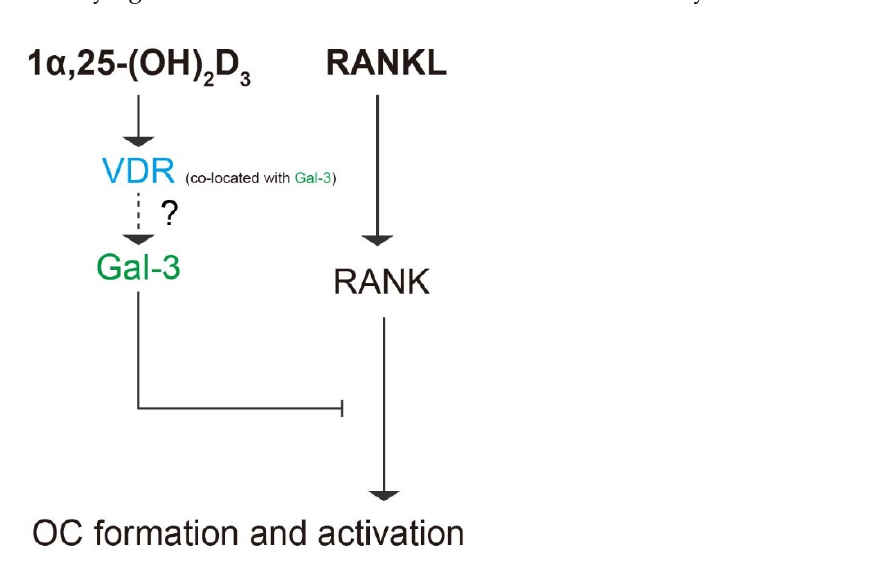
Figure 12. Schematic diagram of the role of gal-3 in OC formation and activation regulated by 1 α ,25- (OH) 2 D 3 . Briefly, 1 α ,25-(OH) 2 D 3 inhibited OC formation and activation induced by RANKL and increased gal-3 expression. Gal-3, a negative regulator of OC formation and activation, colocalized with VDR and contributed to the inhibitory effect of 1 α ,25-(OH) 2 D 3 on OC formation and activation.